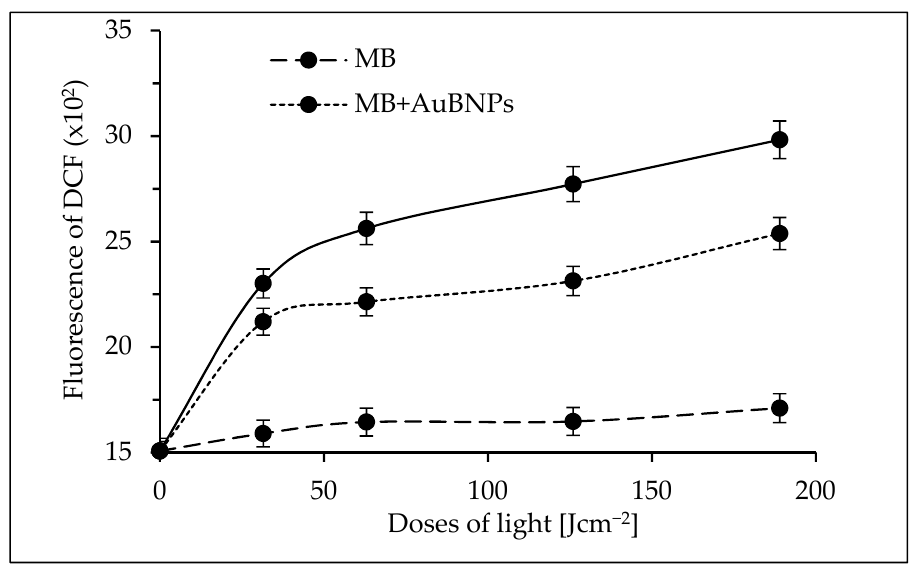
Figure 6. Effectiveness of generating oxidative species by MB alone, MB+AuBNPs, and MB+ChNPs as photosensitizers. The dichlorodihydrofluorescein diacetate as a fluorescent probe was used. Average ± SD of three independent experiments is shown.